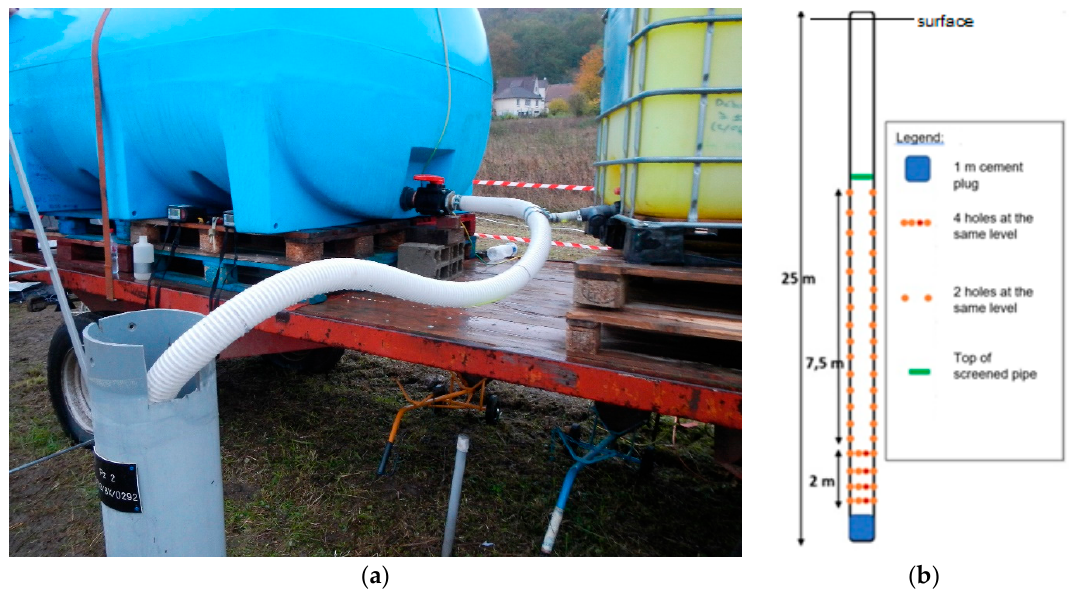
Figure 9. View of injection installation: ( a ) injection pipe and its connection to the tanks; ( b ) diagram of the arrangement of the holes along the injection pipe.